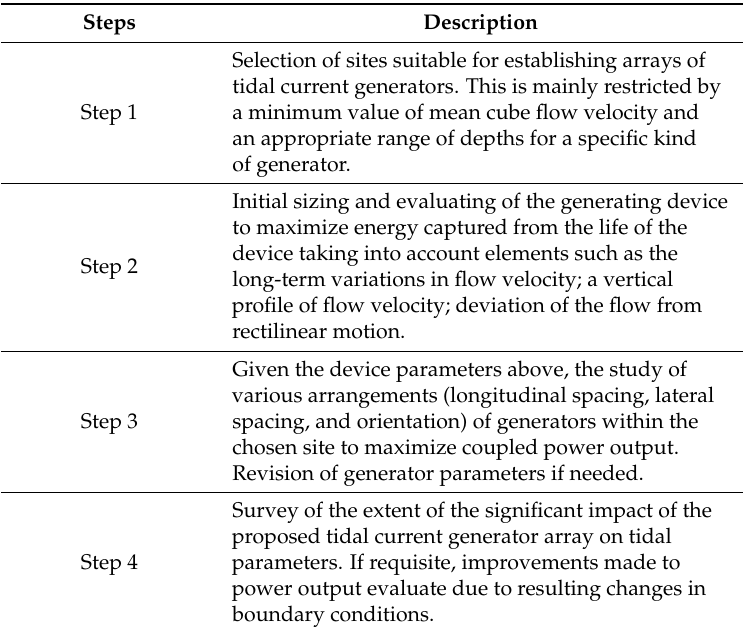
Table 2. Steps required in tidal energy resource